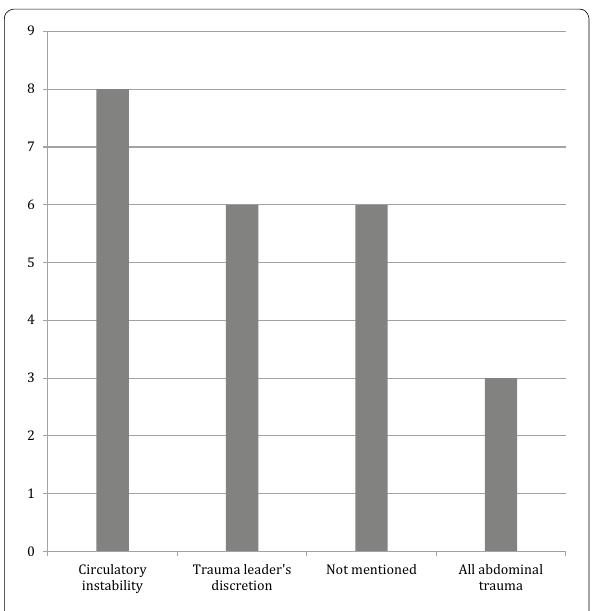
Fig. 3 Indications (total n 23) for performing FAST. Indications for = performing FAST examination mentioned in the trauma manuals and number of hospitals